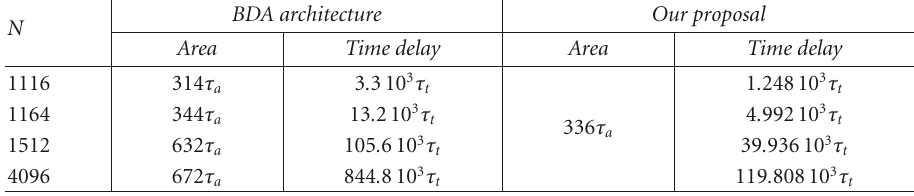
Table 10: Comparison between the BDA and our architecture implementations in terms of τ a and τ t .